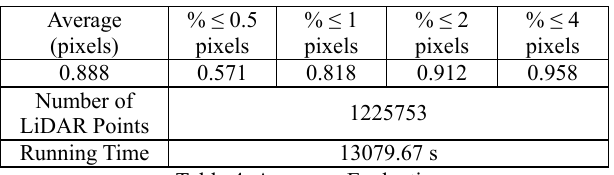
Table 4. Accuracy